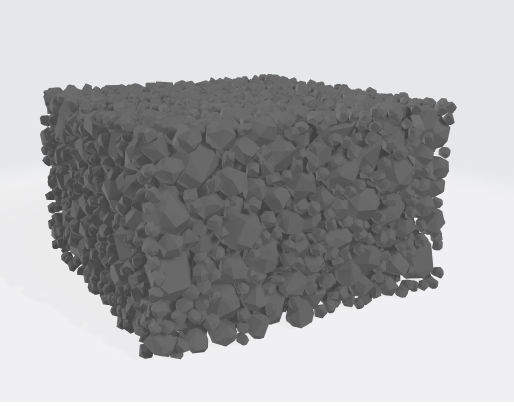
Figure 5. Schematic of the convex aggregate splitting process.